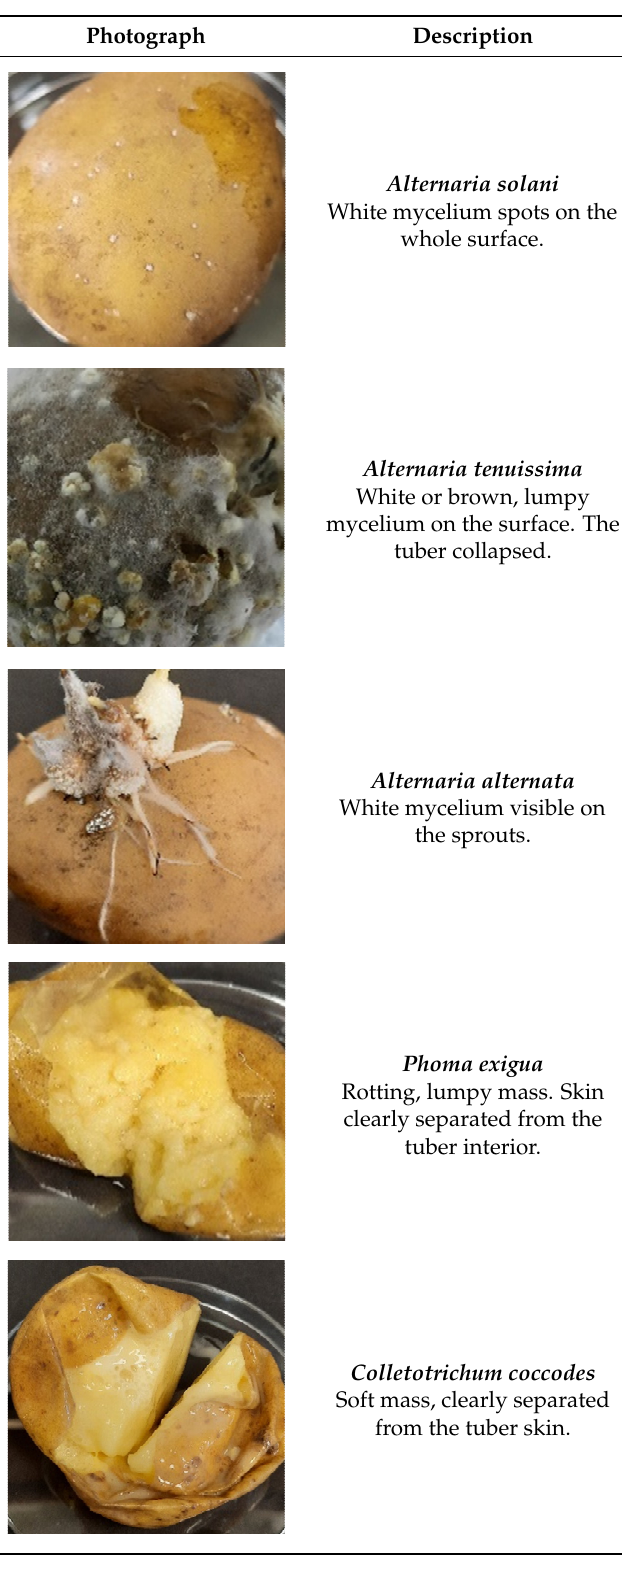
Table 1. Visual assessment of the seed potatoes infestation with phytopathogens.